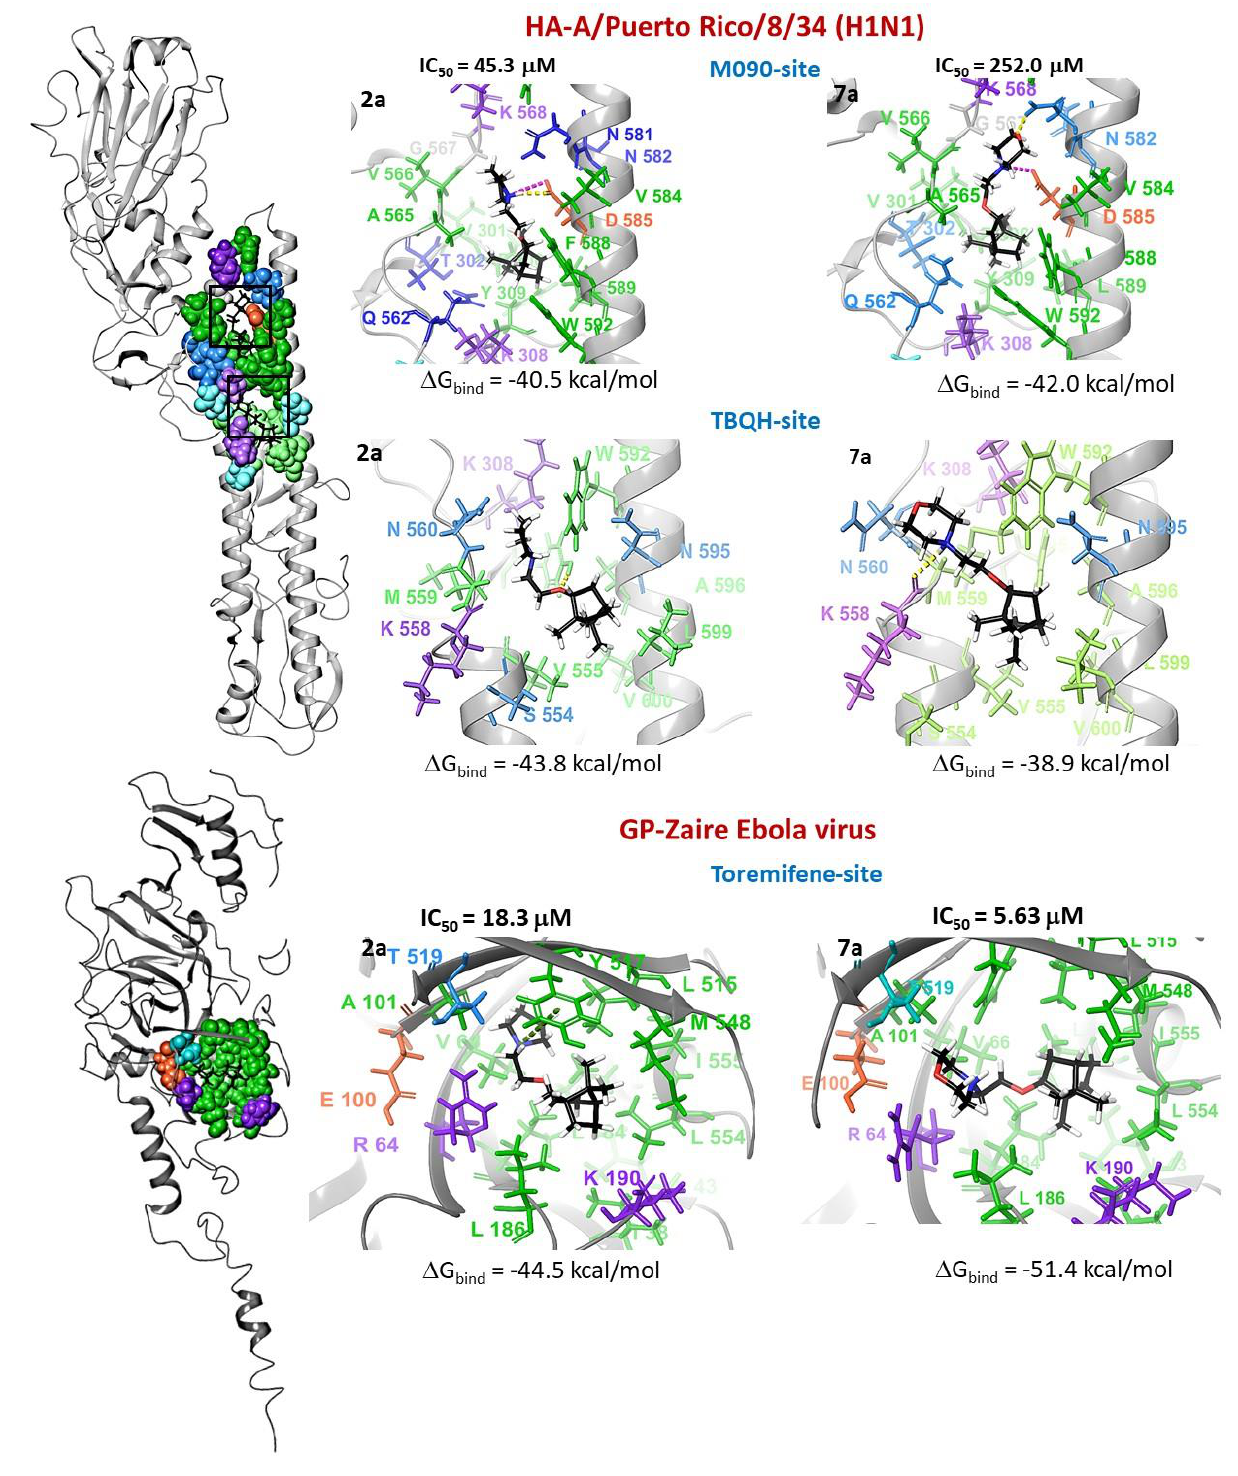
Figure 2. Location of compounds 2a and 7a in the binding sites of influenza virus hemagglutinin strain A/PR/8/34 (H1N1) and Ebola virus glycoprotein. Amino acids included in the binding sites of potential inhibitors are highlighted (green, hydrophobic amino acids; blue, polar amino acids; purple, positively charged amino acids; orange, negatively charged amino acids; glycine is indicated in gray). Interactions are shown by dashed lines (yellow hydrogen bonds; purple salt bridges).